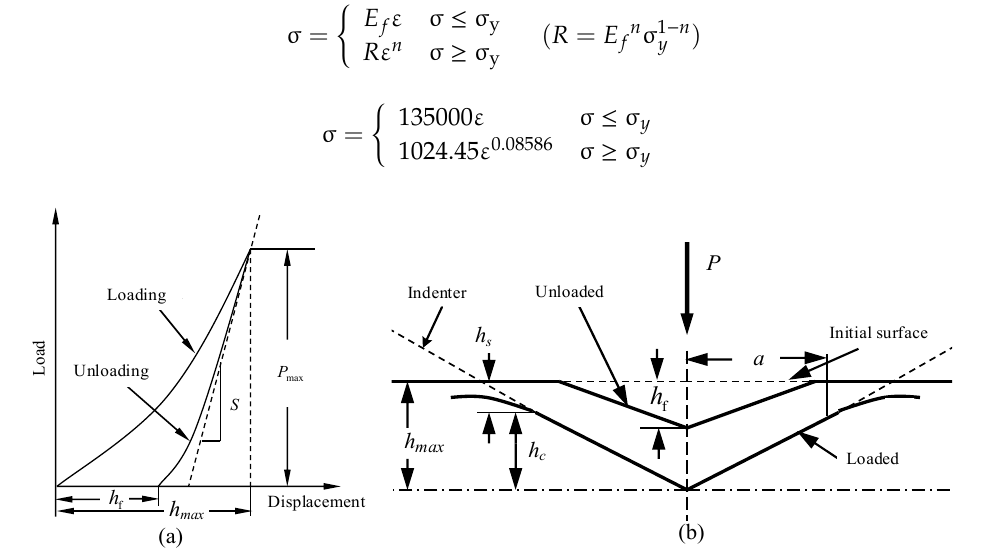
Figure 3. Nano-indentation model: ( a ) Load-displacement curve, ( b ) Cross section of Nano- indentation.